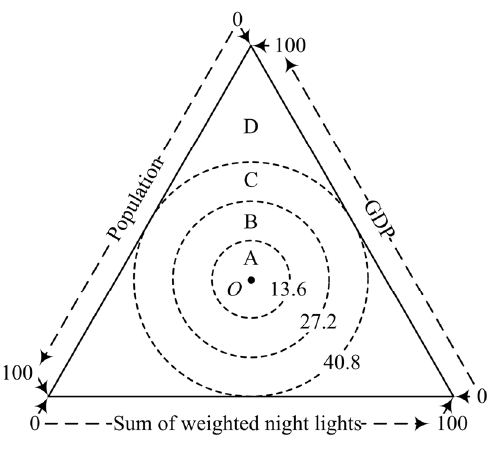
Figure 3. Ternary plot and four types of urbanization processes divided by three equal spacing concentric circles defined by Euclidean distance to point O (the center of the